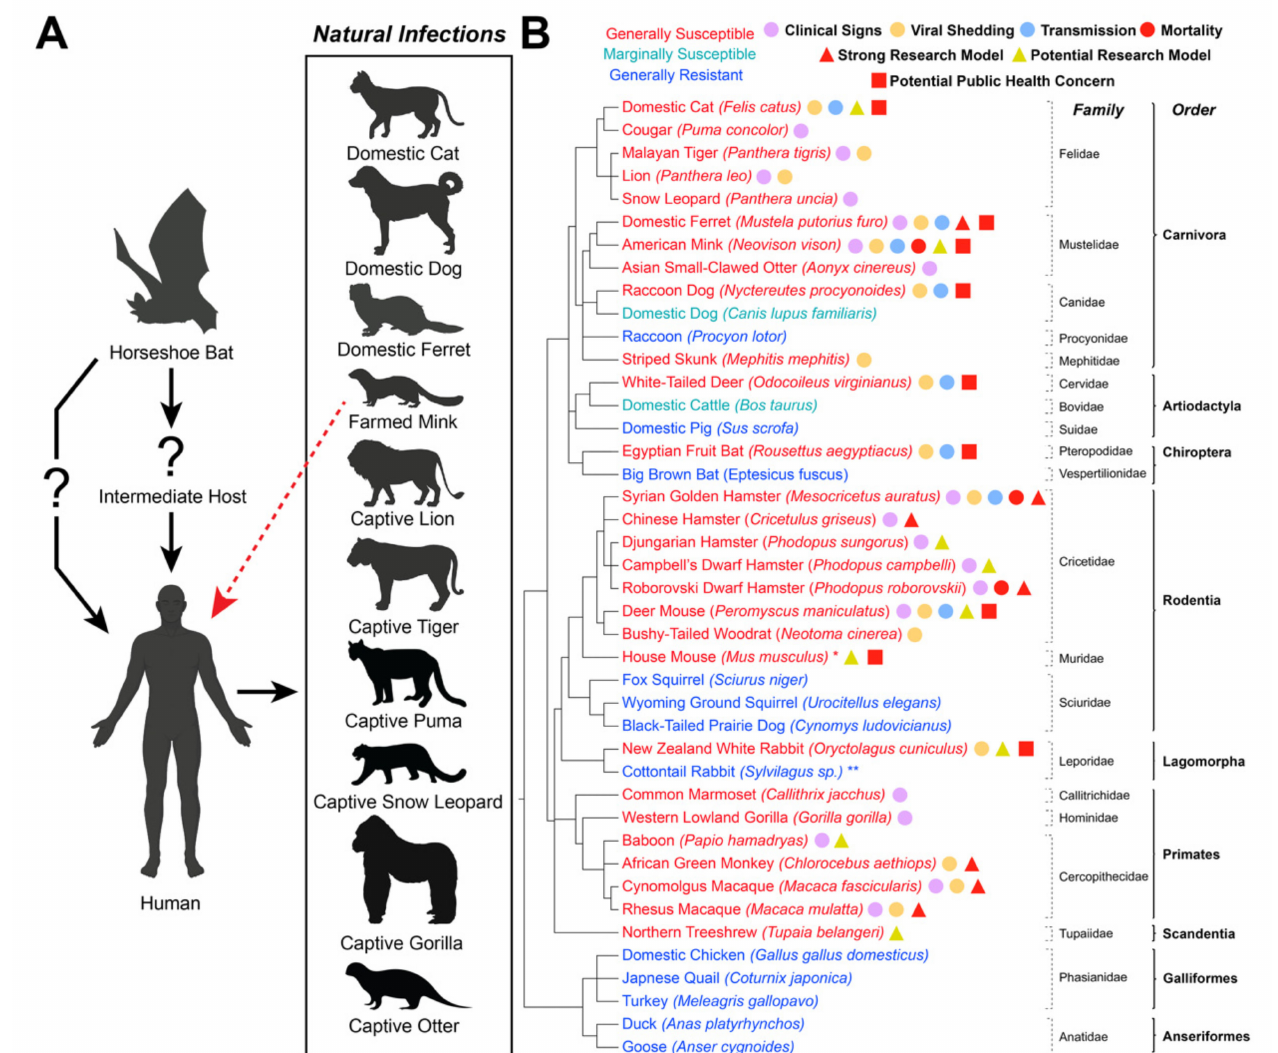
Figure 1. SARS-CoV-2 in Domestic and Wild Animals. ( A ) Disease ecology of SARS-CoV-2. Available evidence suggests that SARS-CoV-2 originated in a horseshoe bat and was then either transmitted directly to humans or through an unidentified intermediate host. Species with documented human-to-animal natural SARS-CoV-2 infections (reverse zoonosis events) are listed, as is the documented mink-to-human transmission of SARS-CoV-2 (red arrow). Created with BioRender.com. ( B ) List of documented species that have either been experimentally or naturally infected with SARS-CoV-2 as of August 2021. Species that are generally susceptible to SARS-CoV-2 are listed in red, marginally susceptible species are listed in cyan, and generally resistant species are listed in blue. * Experimental evidence showed that wild-type mice ( Mus musculus ) are susceptible to mouse-adapted SARS-CoV-2 isolates or certain variants of concern (VOC) that contain an N501Y substitution in the spike protein [138–141] In contrast, gene-edited mice expressing the human angiotensin-converting enzyme 2 (hACE2) receptor are highly susceptible to infection with ancestral and variant SARS-CoV-2 strains [142–149]. ** Cottontail rabbits ( Sylvilagus sp.) were resistant to infection [83], although the dose administered was lower than that required for infection of New Zealand white rabbits [82]; therefore, their true susceptibility is unknown. Clear evidence of outwardly observable clinical signs (violet circle), shedding of infectious virus (orange circle), animal-to-animal transmission (blue circle), and mortality (red circle) upon infection is shown for each species. Species considered strong (red triangle) or potential (yellow triangle) research models are noted, as well as species with a potential public health concern (red square). Phylogenetic tree was produced using the phyloT v2 server (https://phylot.biobyte.de, accessed on 26 June 2021) based on the NCBI taxonomy